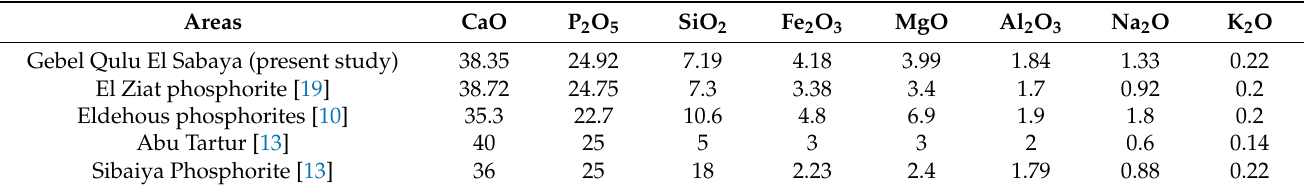
Table 2. Comparison of the examined major oxides (wt.%) of Qulu El Sabaya phosphorites with some Egyptian